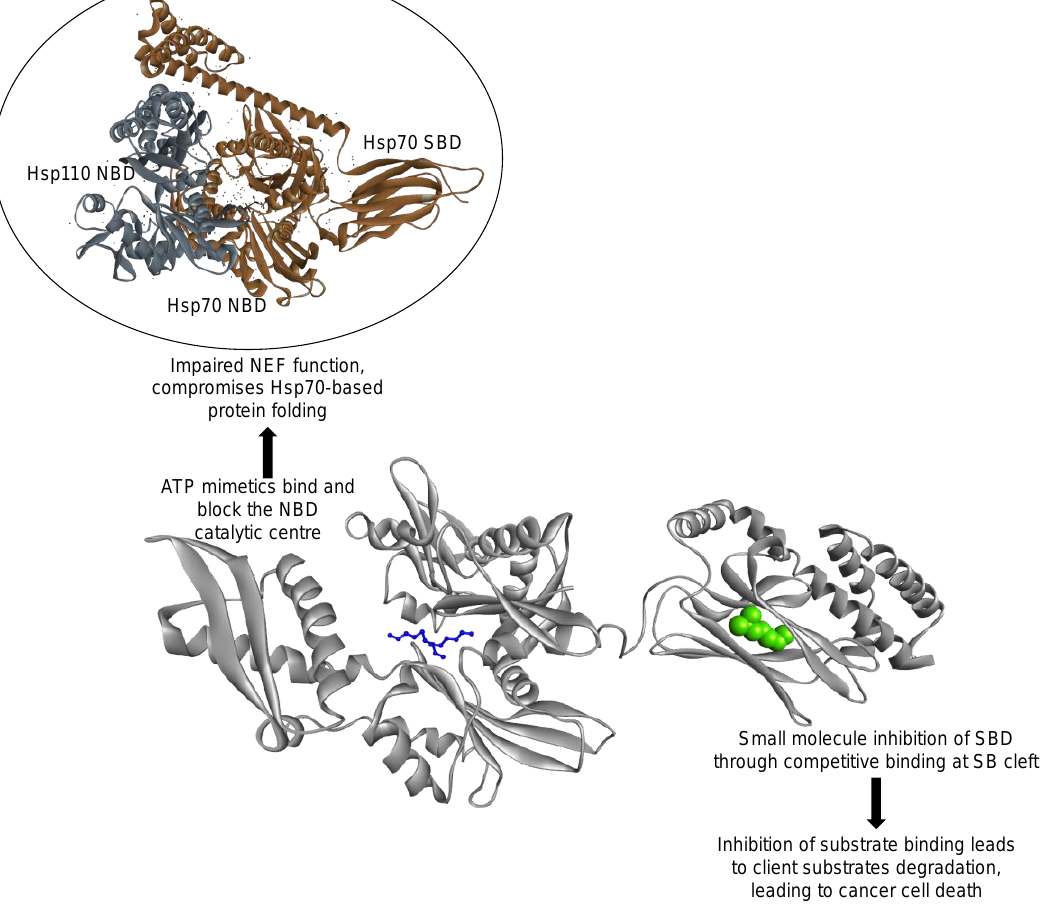
Figure 6. Proposed strategies for targeting Hsp110: Small molecule inhibitors that bind and block the NBD of Hsp110 abrogate its nucleotide exchange function on canonical Hsp70. Peptide mimetics also constitute possible Hsp110 inhibitors that abrogate its chaperone